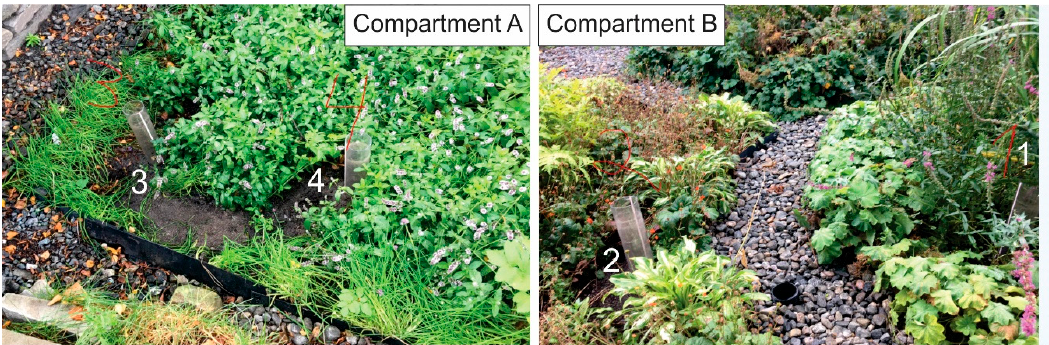
Figure 9. MPD infiltration tests where MPD 3 and 4 were measured in the smaller compartment A (picture on the left) and MPD 1 and 2 were measured in the larger compartment B (picture on the right). Photo: Torstein Dalen, Bergen